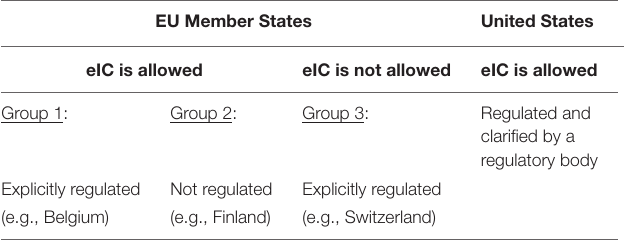
TABLE 2 | The acceptance of electronic informed consent in the European Union and United States. EU Member